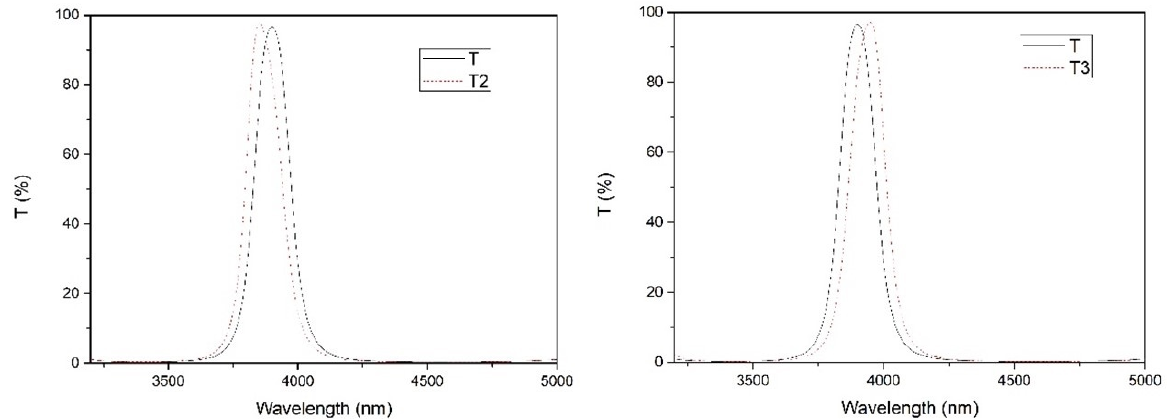
Figure 6. Comparison of design curve and test curve based on general optical monitor (T2) and crystal monitor system